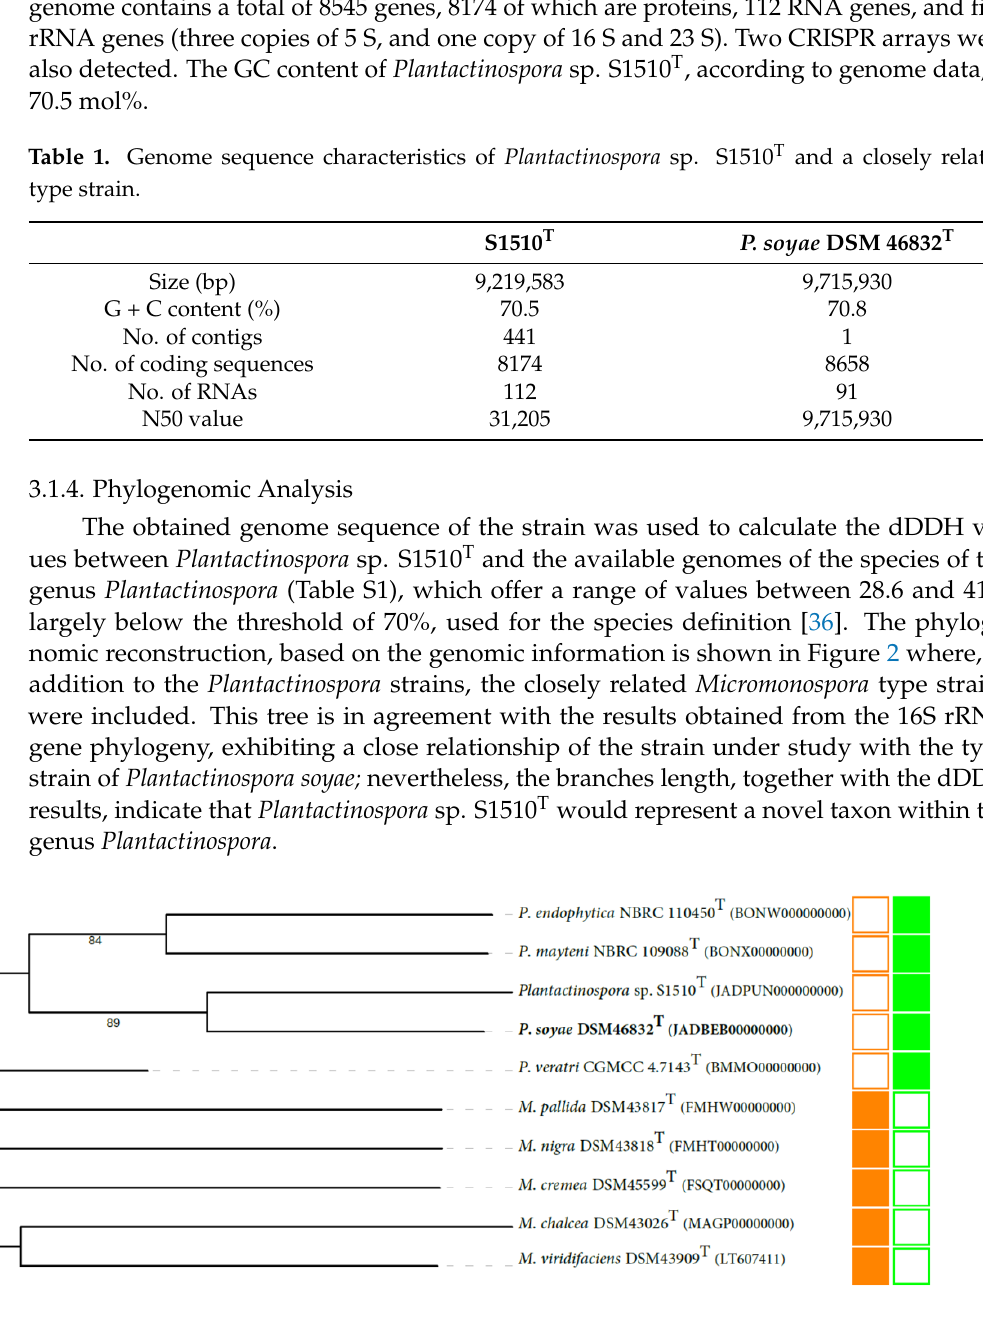
Figure 2. Whole genome phylogenetic tree generated with TYGS of the strain of the study and the closely related strains with available genomes. The tree was inferred with FastME from GBDP distances calculated from the genome sequences. Branch lengths are scaled in terms of the GBDP distance formula d5 and the numbers above the branches indicate the GBDP pseudo -bootstrap support values from 100 replications.